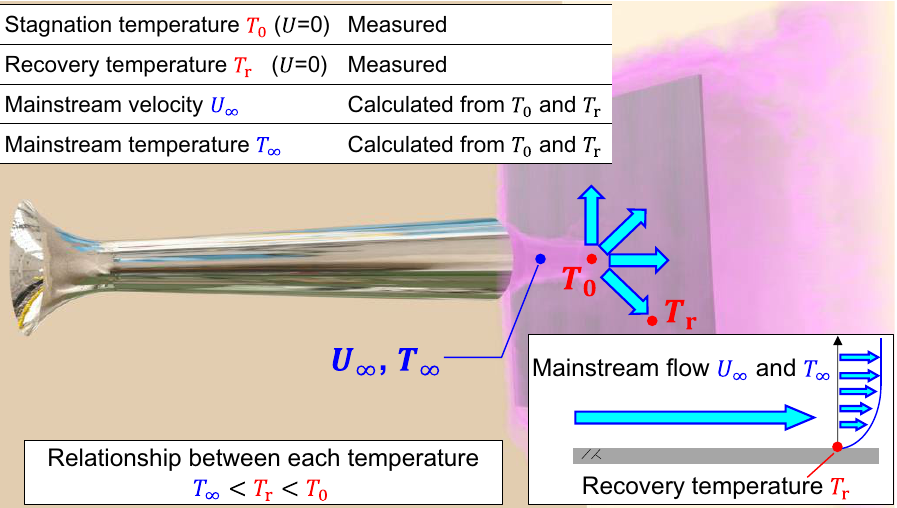
Figure 1. Conceptual diagram of stagnation temperature T 0 and recovery temperature T r . Both T 0 and T r are points on the wall, and therefore, the flow velocity is zero. However, T r is lower than T 0 because of the effect of the temperature gradient in the main flow. The flow velocity in the mainstream is proportional to the square of the difference between T 0 and T r